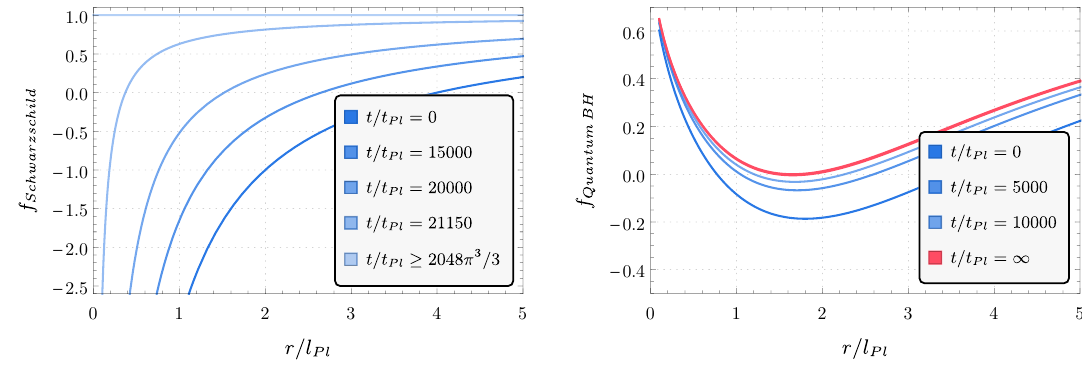
Figure 9 . Schwarzschild (left panel) and quantum-corrected lapse function (right panel) at different times. Classically, the Hawking temperature increases monotonically as the black hole mass is converted into Hawking quanta. The evaporation thus continues for a finite amount of time ∆ t = 2048 π 3 / 3 t until the mass m vanishes and the classical black hole reduces to a Minkowski spacetime Pl with a naked singularity at r = 0 . The corresponding lapse function is one everywhere except at the origin, where it diverges. In the quantum model, evaporation takes an infinite amount of time and a black hole remnant with mass m (solid red line) is formed c ∼ m Pl